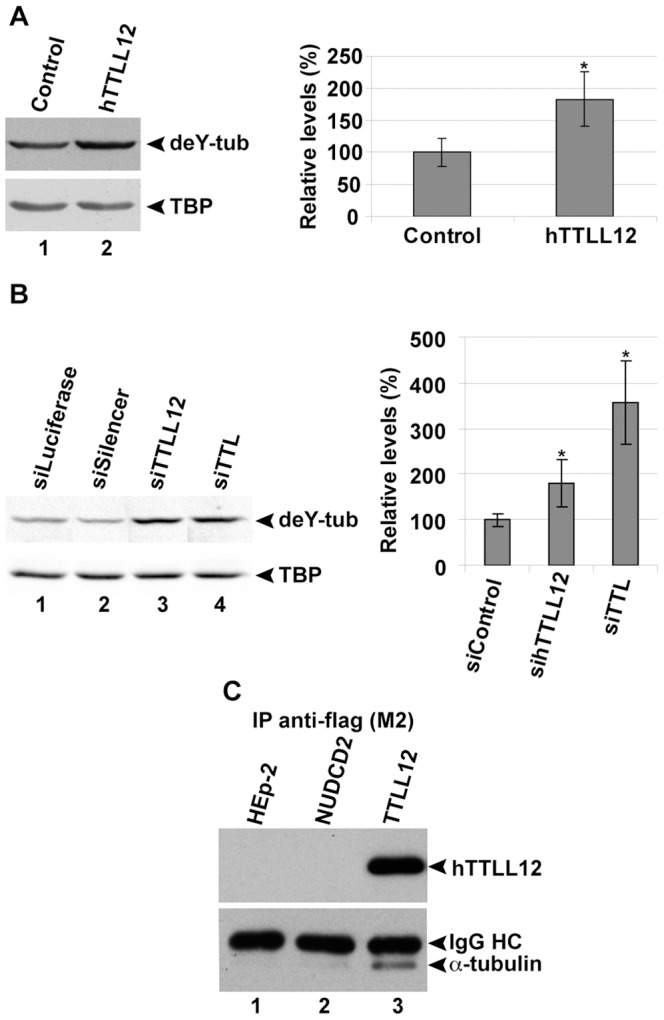
hTTLL12 alters detyrosinated tubulin levels and co-immunoprecipitates with α-tubulin.
A. hTTLL12 (hTTLL12_A-E) or Control (Control_A, _B, _D, _E) clones were harvested in Laemmli buffer and analysed by SDS-PAGE and WB. Representative WBs (left part) for detyrosinated tubulin (deY-tub) and TBP (40 µg total protein/lane; Control_D and hTTLL12_B shown). deY-tub levels from similar WBs were quantified by densitometry and normalised to TBP (right part). Data represent average detyrosinated tubulin levels ± SEM in hTTLL12 lysates relative to average levels in control lysates (n = 2). * Statistically significant difference to the controls (P<0.05, Student's t-test). B. HEp-2 cells were transfected with 10 nM control siRNAs (siLuciferase, siCtrl, siGFP or siSilencer), 10 nM hTTLL12-specific siRNA (sihTTLL12_1-6), or 10 nM positive control siRNA (siTTL_1-2). 72 hours after transfection, cells were lysed in Laemmli buffer and analysed by SDS-PAGE and WB. Chemiluminescent signals were detected using a Versadoc image station. Representative WBs (left part) for detyrosinated tubulin (40 µg of total protein/lane) and TBP signals (note that lanes 1–3 of the TBP blot are identical to the ones shown in the upper left part of Figure 2B) in siLuciferase, siSilencer, sihTTLL12_2 and siTTL_2 lysates. Detyrosinated tubulin levels were quantified using Quantity One software and normalized to TBP (right part). Data represent average detyrosinated tubulin levels ± SEM in sihTTLL12 and siTTL lysates relative to average levels in control siRNA lysates (siControl; n = 5). * Statistically significant difference to the levels in siControl (P<0.05, Student's t-test). C. Representative WB showing the co-immunoprecipitation of α-tubulin with Flag-hTTLL12 immunoprecipitated from the stable clone hTTLL12_A (lane 3). Similar results were obtained with 4 other clones (hTTLL12_B-E, data not shown). Parental HEp-2 cells (lane1) and a stable HEp2-clone overexpressing Flag-NudCD2 (lane 2) were used as negative controls. IgG HC: IgG heavy chain.